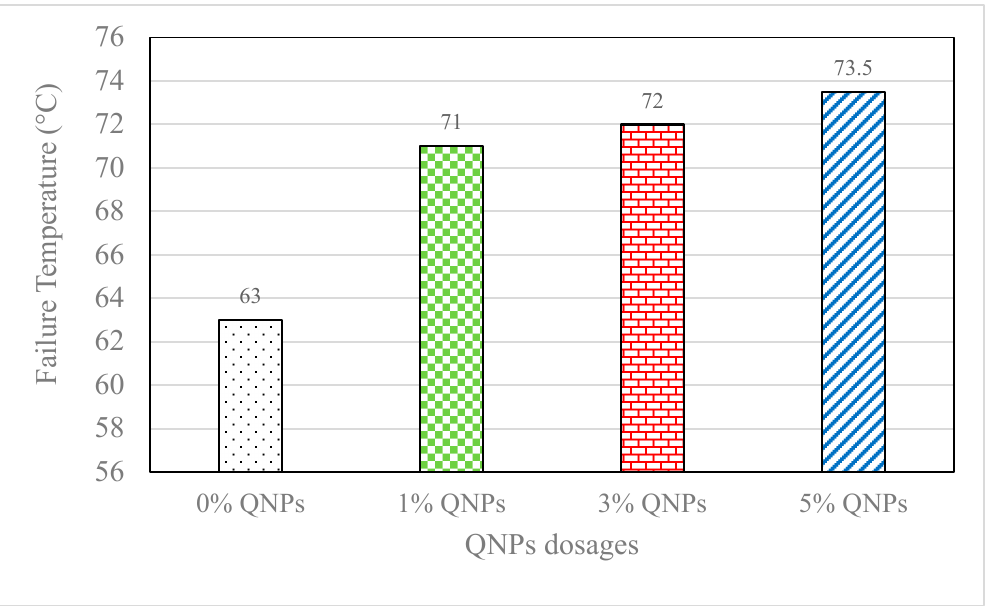
Figure 15. Influence of QNP dosages on performance grade (PG). Table 8. Average POTS (psi) values of base and QNP-modified bitumen and failure